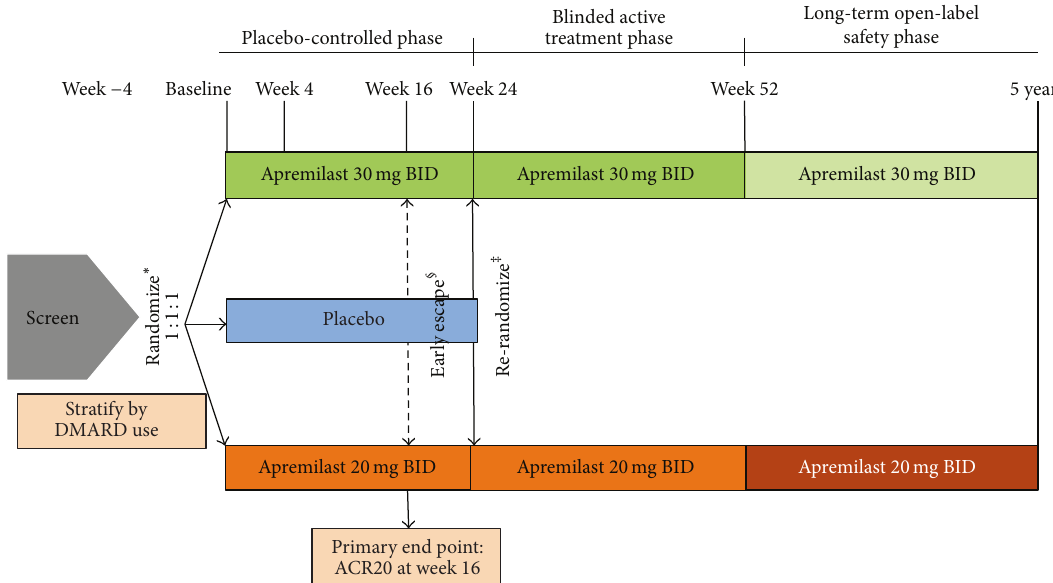
Figure 1: The PALACE 1 study design. Plasma samples for the biomarker assay were obtained at baseline and at Weeks 4, 16, and 24. ∗ All doses were titrated over the first week of treatment. § Patients whose swollen and tender joint counts had not improved by ≥ 20% at Week 16 were considered nonresponders and were required to be rerandomized (1:1) to apremilast 20mg BID or 30 mg BID if they were initially randomized to placebo, or continued on their initial apremilast dose. ‡ At Week 24, all remaining placebo patients were rerandomized to apremilast 20mg BID or 30mg